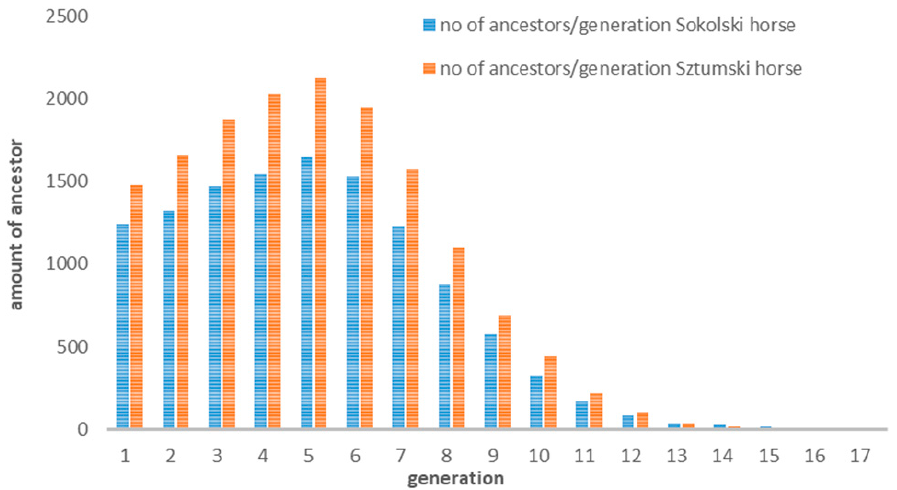
Figure 4. The numbers of available pedigree information in subsequent generations.